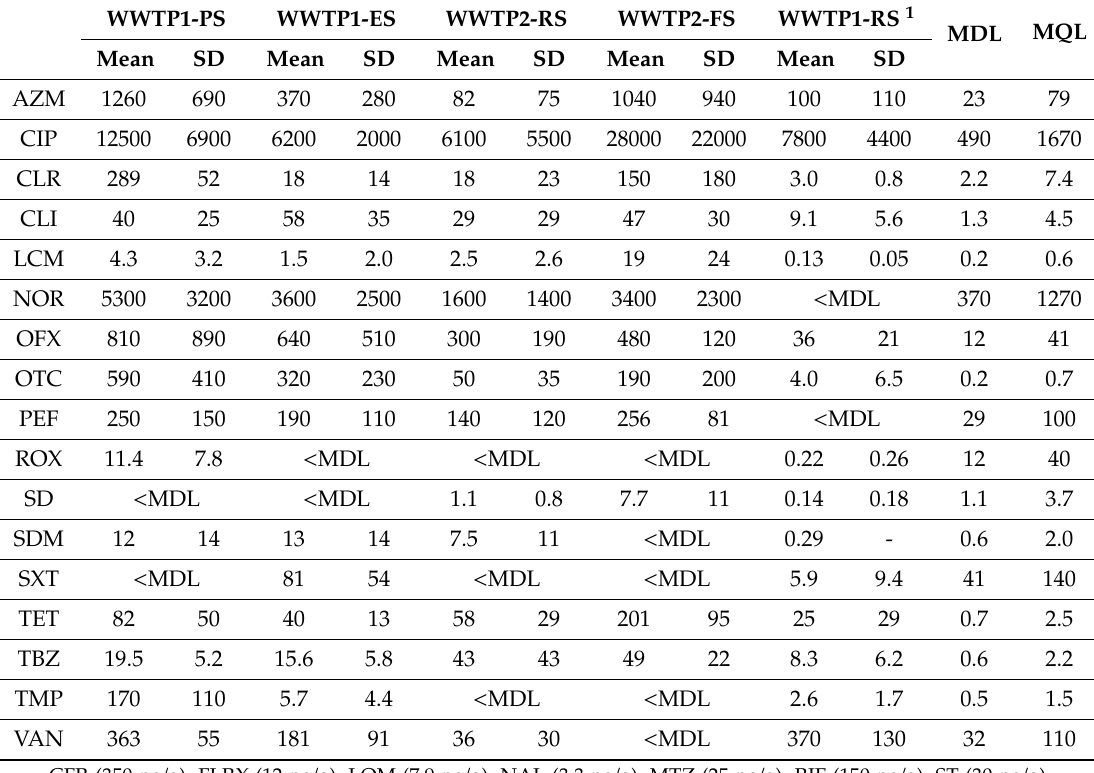
Table 2. Mean and standard deviation ( n = 3) of target antimicrobial concentration (ng / g dry weight) in sewage sludge samples in two wastewater treatment plants (WWTPs) located in Poland at Silesian (WWTP1) and Warmian-Masurian Voivodship